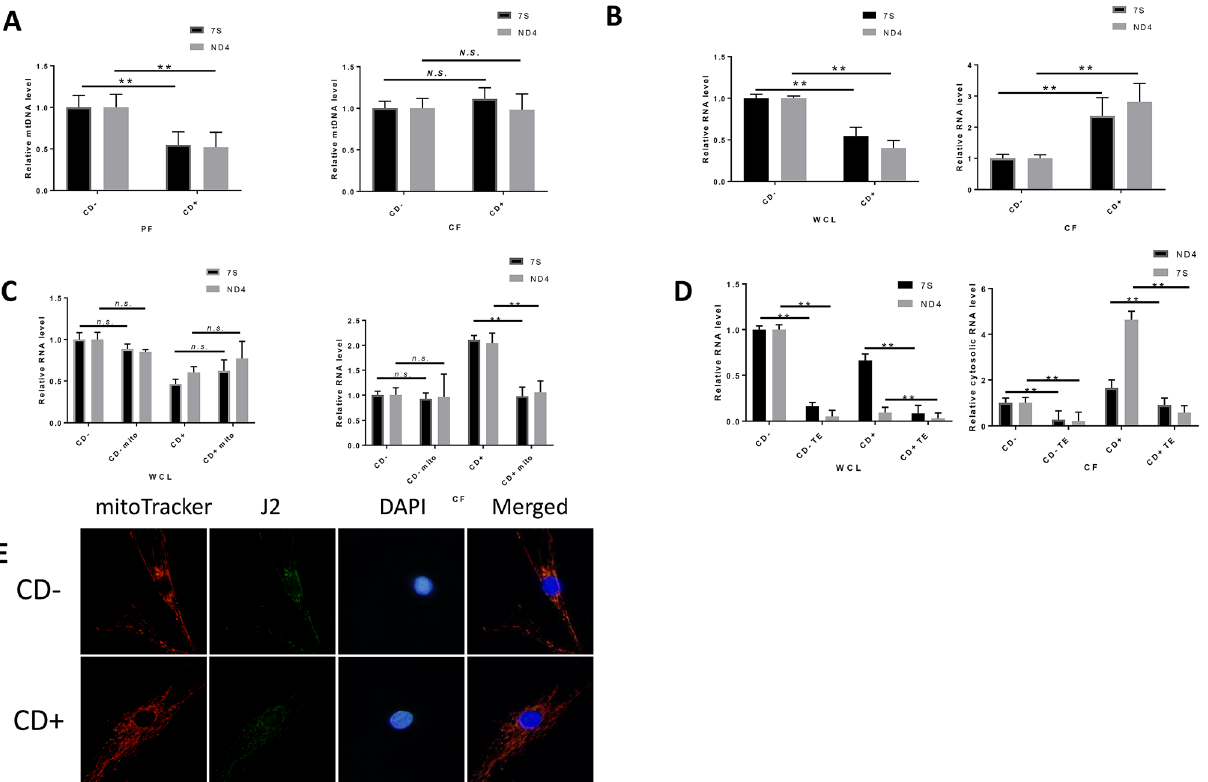
Figure 3. Higher level of mtdsRNA in the cytoplasm of CD+ keratocytes compared to in that of CD− keratocytes. ( A ) The relative level of mtDNA in the pellet fraction (PF) or cytosolic fraction (CF) measured by multiplex qPCR ( n = 3). ( B ) Relative mtRNA in whole-cell lysate (WCL) and CF of CD+/− keratocytes measured by multiplex qPCR ( n = 3). ( C ) Relative mtRNA in CF of CD+ keratocytes 24 h after 10 μM mitoTEMPO treatment ( n = 3). ( D ) Mitochondrial RNA level with/without Terminator 5 ′ -phosphate-dependent exonuclease treatment (TE) in WCL and CF ( n = 3). ( E ) Representative fluorescence image of dsRNA in CD+/− cells. mitoTracker (red), J2 foci (greed) and DAPI (blue) were merged in the right column (merged). Values are means ± SD. n.s. (not significant); *P < 0.05, **P <